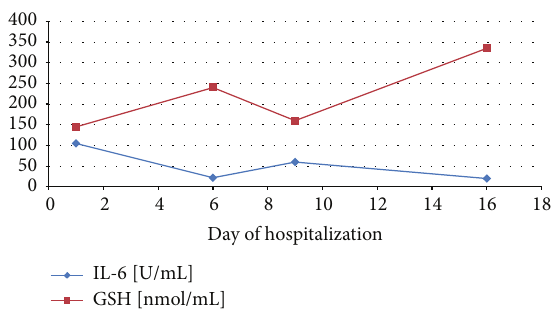
Figure 2: Dynamics of the changes in GSH level and IL-6 concen- tration in patient 2 with acute